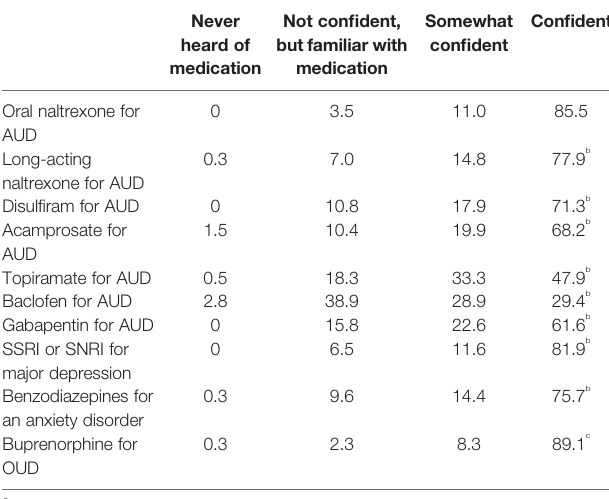
TABLE 2 | Prescribers ’ ratings of con fi dence in their knowledge of medication ’ s indications, contraindications, and most frequent adverse events (n = 397) a . Never heard of